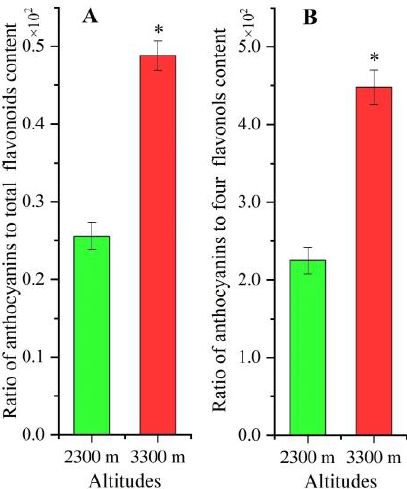
Figure 1. The content of total flavonoids ( A ), light intensity ( B ), content of target flavonoid ( C ), total target flavonoid ( D ), and anthocyanins ( E ) at 2300 and 3300 m. The * represents a significant difference ( p < 0.05) between 2300 and 3300 m (mean ± SD, n = 3).